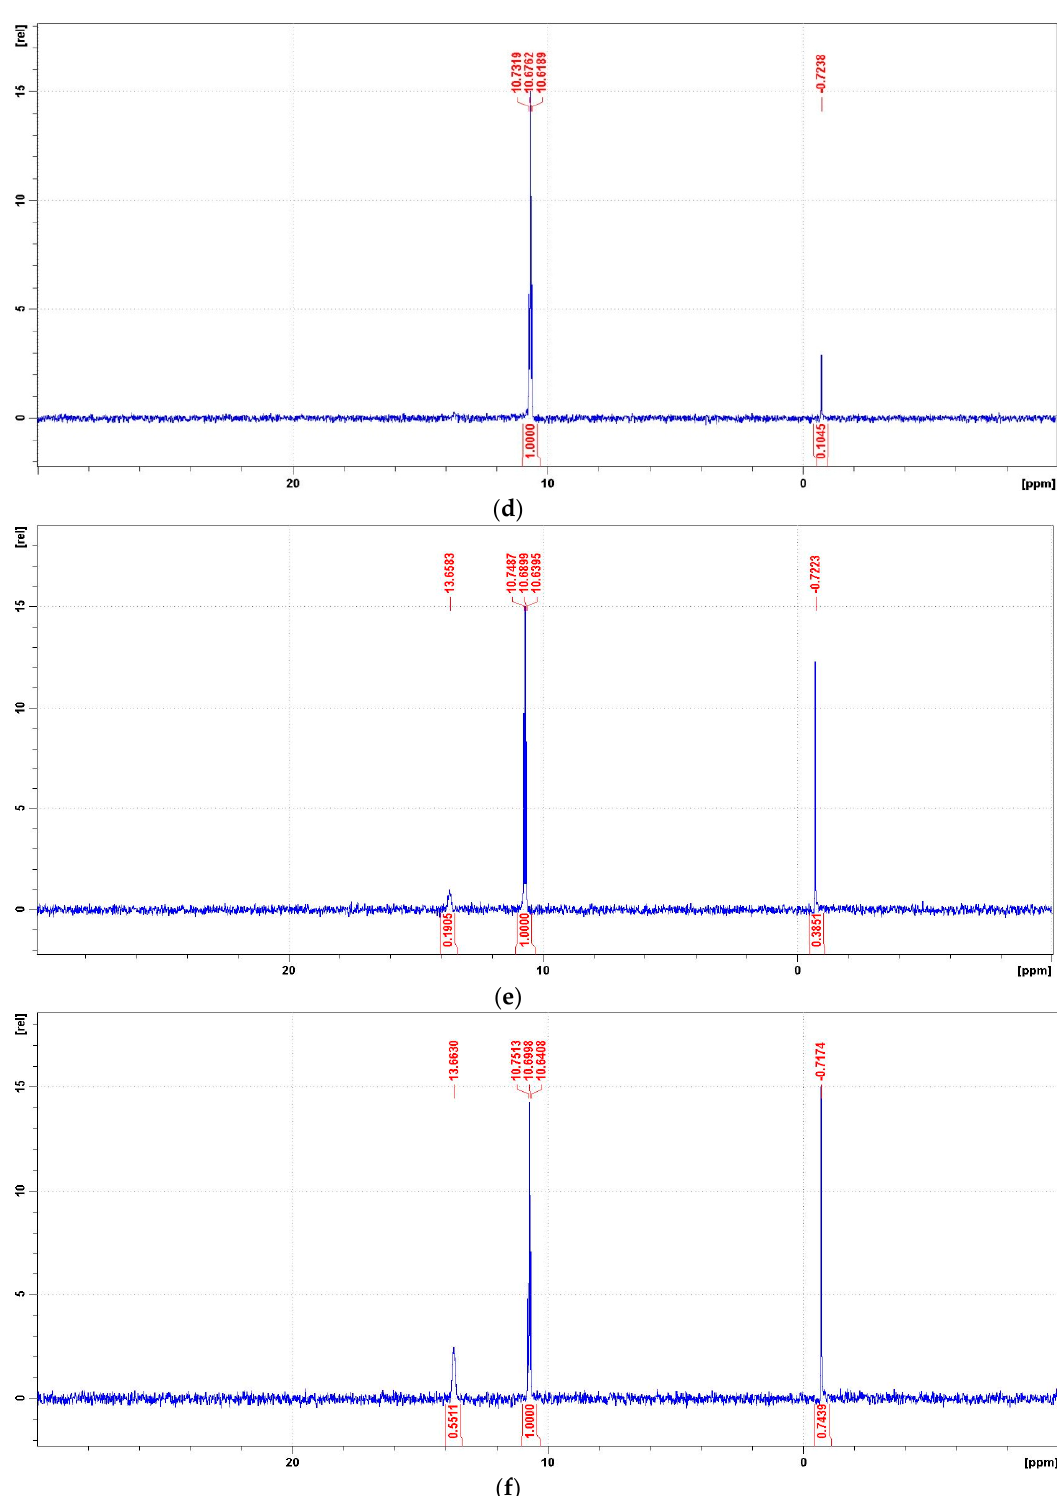
Figure 11. Representative 31 P NMR spectra of the degradation mixtures of PMG-H 2 O 2 -(UV) carried out at pH = 2–12 (UV; 25 °C), recorded after a given reaction time. ( a ) 31 P NMR spectrum of the reaction mixture recorded before radiation (dissolved in 2 M H 2 SO 4 /D 2 SO 4 /); ( b ) reaction mixture after UV radiation at pH = 2 (reaction time 360 min); ( c ) reaction mixture after UV radiation at pH = 8 (reaction time 360 min); ( d ) reaction mixture after UV radiation at pH = 10 (reaction time 360 min); ( e ) reaction mixture after UV radiation at pH = 12 (reaction time 30 min); ( f ) reaction mixture after UV radiation at pH = 12 (reaction time 360 min).